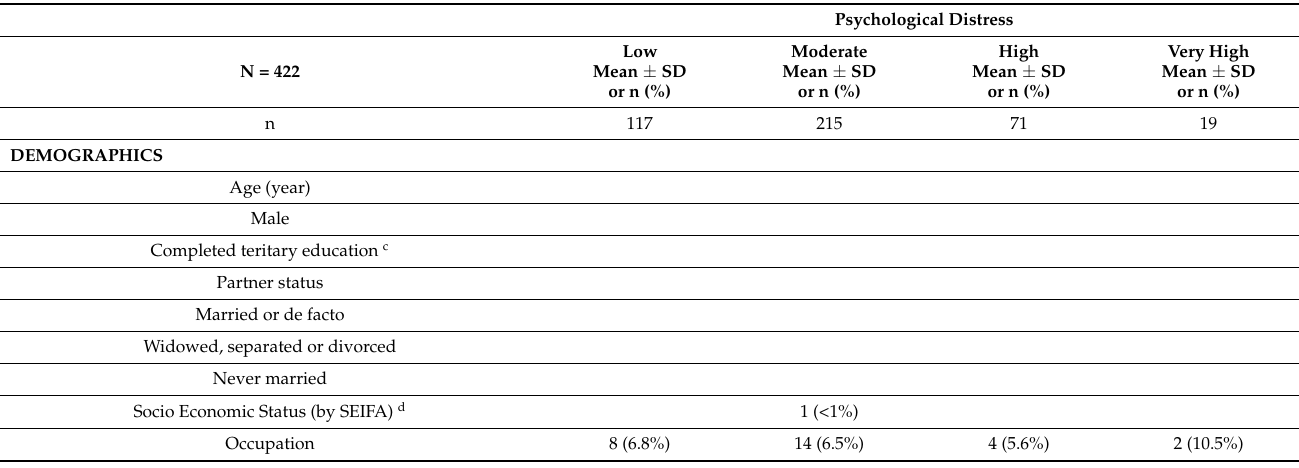
Table A1. Missingness. Blank indicates none missing.